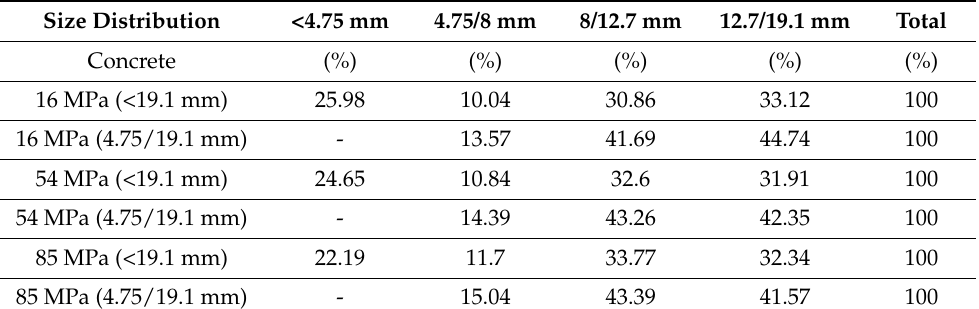
Table 2. Concretes comminuted at a top size of 19.1 mm in two size ranges: <19.1 mm and 4.75/19.1